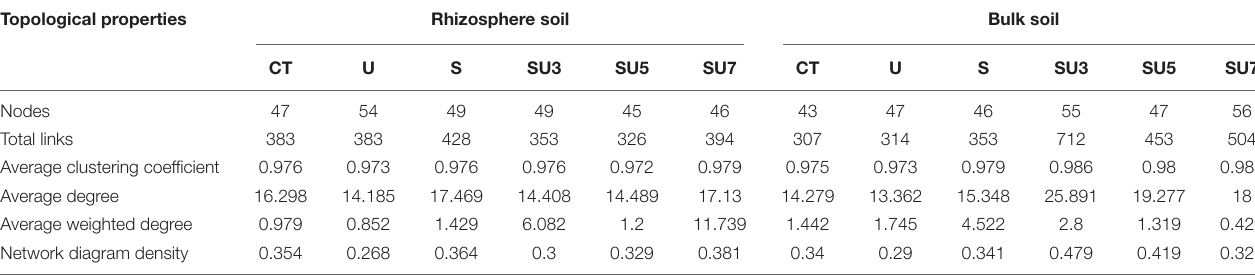
TABLE 2 | Network topological characteristics in rhizosphere soils and bulk soils at the maize physiological maturity under different N fertilizer treatments. Topological properties